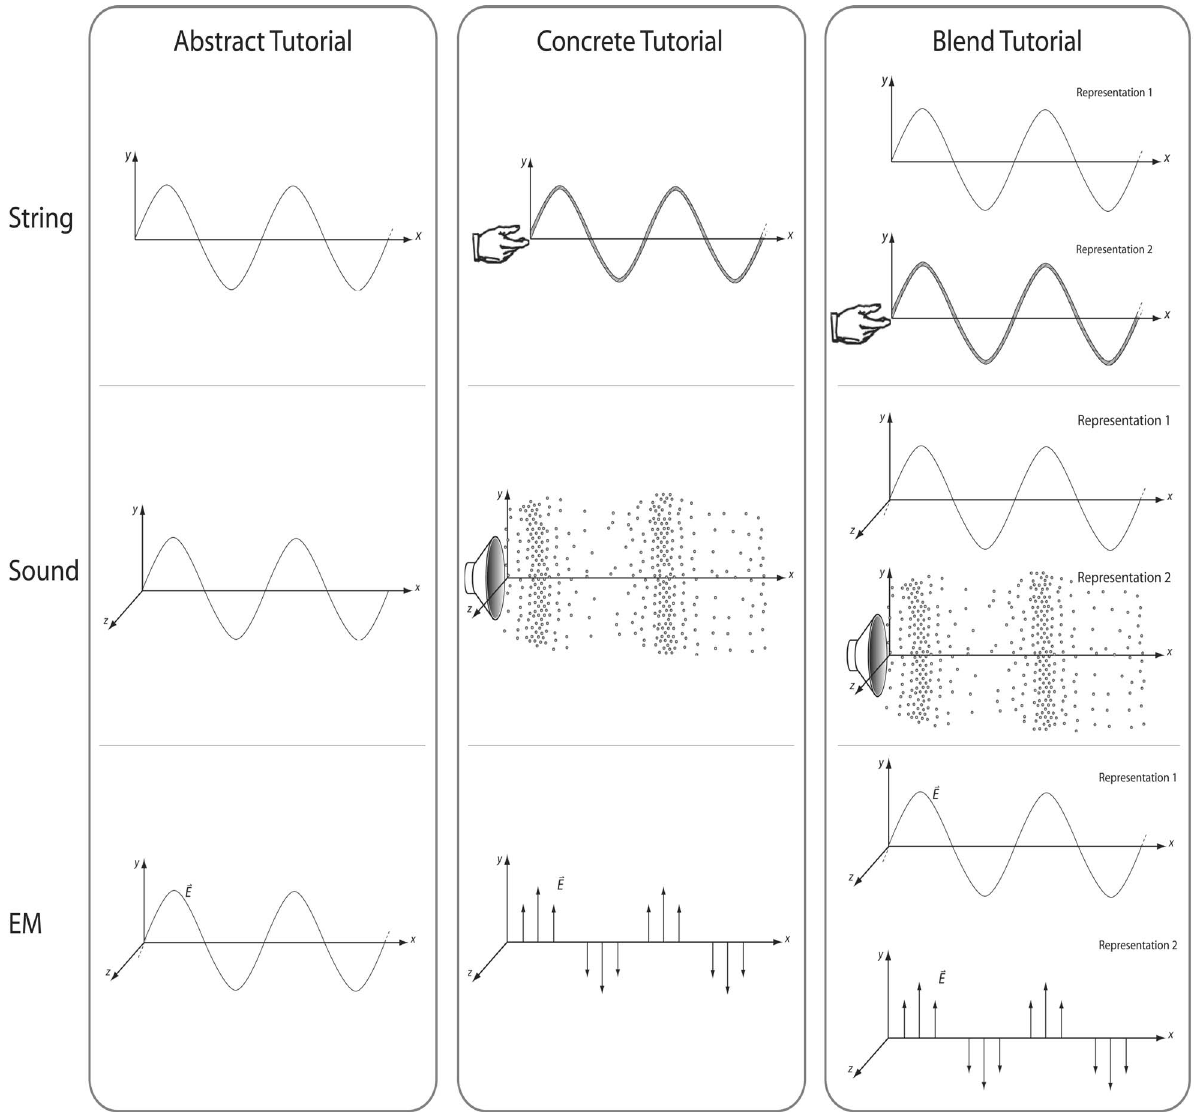
FIG. 3. Examples of representations of a wave on a string, sound wave, and EM wave used in the abstract, concrete, and blend tutorials in the across-domain study. The complete set of representations can be found in the supplementary materials (cid:1) Ref. 40 (cid:2)